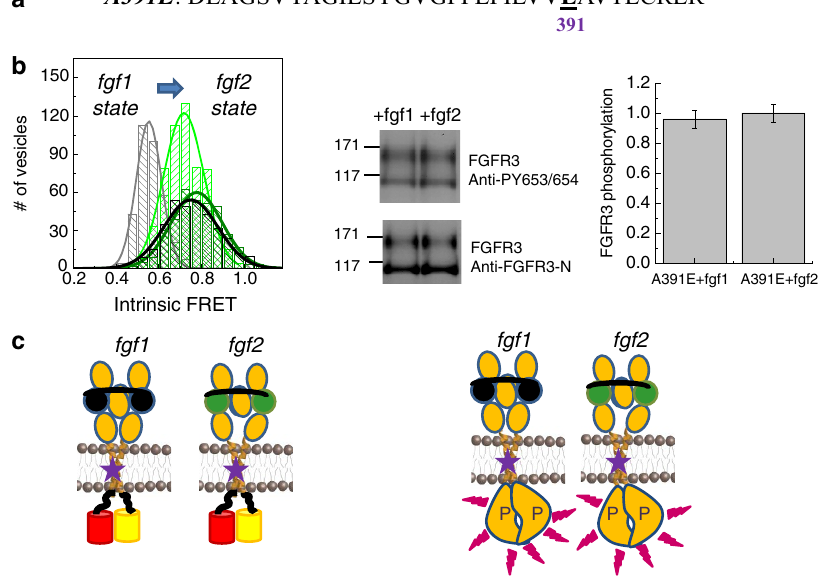
Figure 6 | Effect of the pathogenic A391E FGFR3 mutation on dimer structures in the fgf1- and fgf2-bound states. The A391E mutation is the genetic cause for Crouzon syndrome with acanthosis nigricans, a cranial abnormality 57 , and has been linked to bladder cancer 8 . ( a ) Sequence of the A391E TM domain, with the mutation underlined. ( b ) Intrinsic FRETvalues, measured for the A391E EC þ TM mutant in the presence of saturating concentrations of fgf1 or fgf2. The histograms for the wild type are shown in grey in the presence of fgf1 and in green in the presence of fgf2. The histograms for the A391E mutant are shown in black in the presence of fgf1 and in olive in the presence of fgf2. The intrinsic FRET values measured for the A391E mutant in the presence of fgf1 shift up, such that they overlap with the fgf2 wild-type values. Thus, the A391E mutation abolished the fgf1-bound state. ( b ) Western blots showing expression, as assayed by anti-FGFR3 antibodies, and phosphorylation of the tyrosines in the activation loop, as assayed by anti-phospho-Y653/4 antibodies. The phosphorylation of the mature fully glycosylated A391E mutant (top bands) is identical in the fgf1 and fgf2-bound states ( P 4 0.01), and is the same as the phosphorylation of the wild type in the fgf2-bound state. Data are from three independent experiments. Thus, the A391E mutation increases the phosphorylation in the fgf1 state to fgf2-state levels. ( c ) Graphic representation of the finding that the A391E mutation abolishes the fgf1-bound state and induces a transition to the fgf2 state. Left: graphic representation of the finding that the average distance between the fluorescent proteins is the same in the presence of both fgf1 and fgf2. Distances are not drawn to scale. Right: graphic representation of the finding that phosphorylation is also the same in the presence of fgf1 and fgf2. The representation of the kinase domains is not based on structural